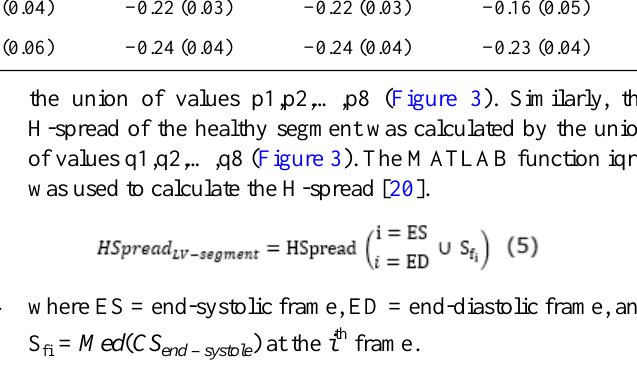
Figure 3. Representation of an infarcted and a healthy segment using circumferential strain. (a) End-systolic strain in a healthy segment (q8) and an infarcted segment (p8). (b) pi and qi represent median strain values at the ith frame of a cardiac cycle. (c) Strain HSpread is calculated using (Equation